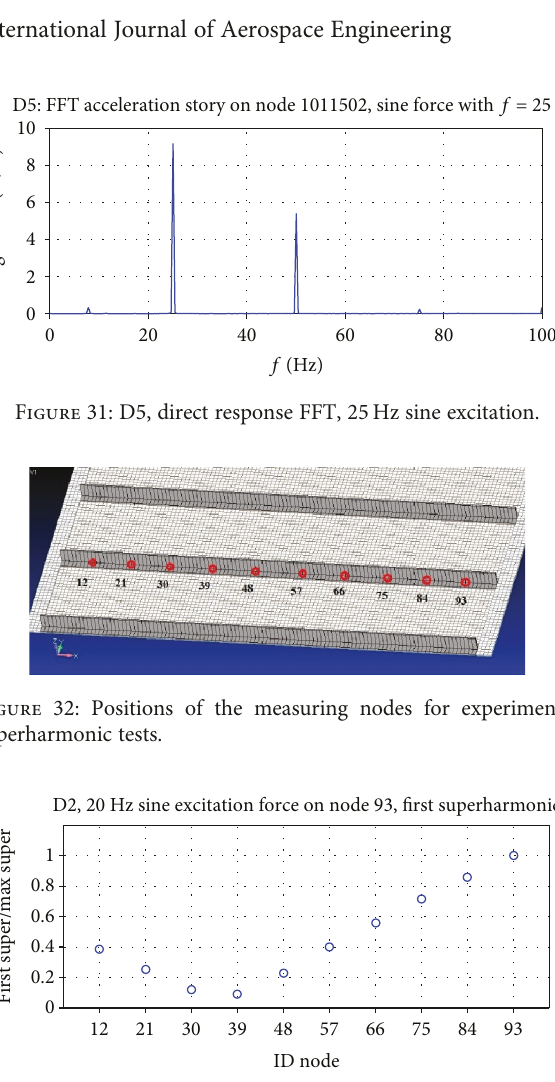
Figure 33: D2, 20 Hz excitation, normalized 1st superharmonic.